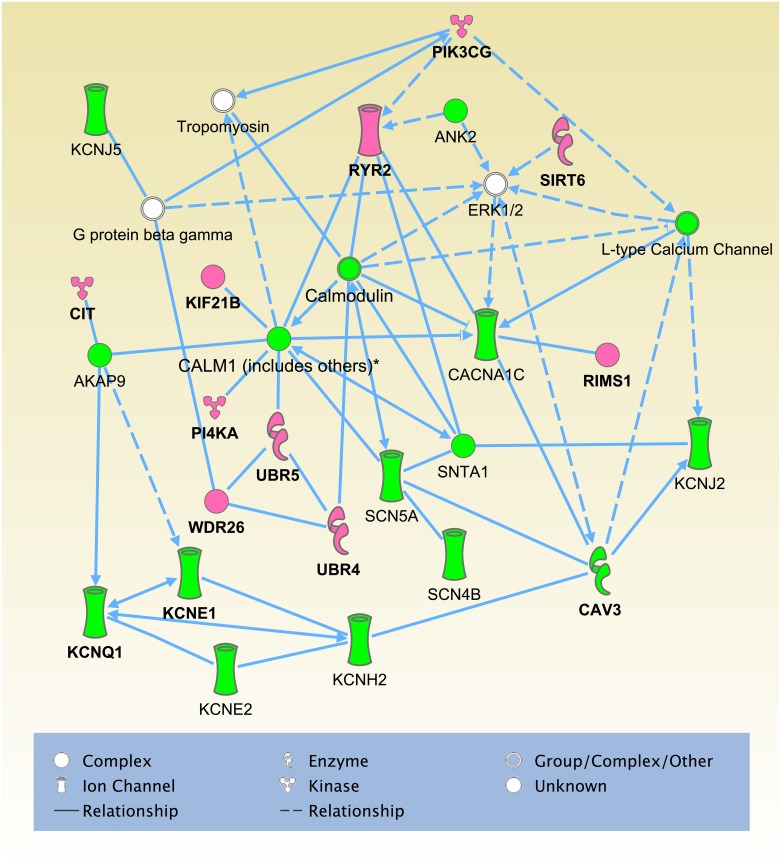
The top-scoring IPA network constructed on the basis of known genes/proteins and candidate pathogenic genes/proteins identified.The green and pink objects represent known LQTS genes and candidate pathogenic genes identified in this PPI analysis, respectively.